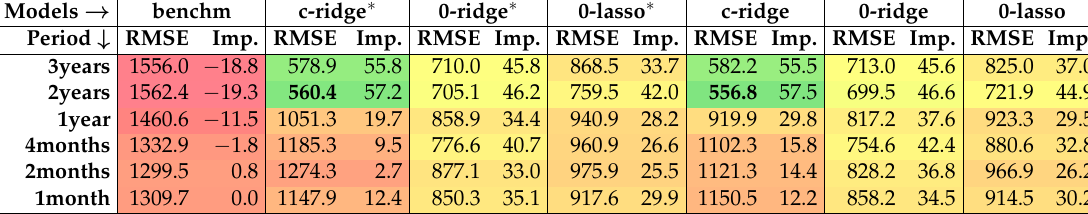
Table 2. Out-of-sample RMSE in MW with relative improvement in % with respect to the benchmark trained on the shortest training period for all models and training periods. A heat map is used to indicate better ( green) and worse ( red) performing → →